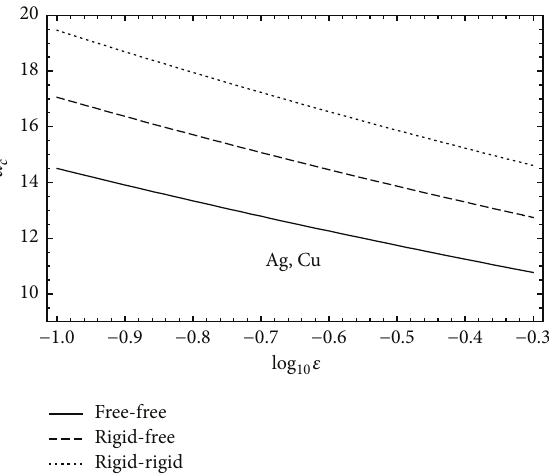
Figure 3: Plot of 𝛼 𝑐 with Darcy number for fixed 𝑄 = 250 and 𝜀 = 0.4 .